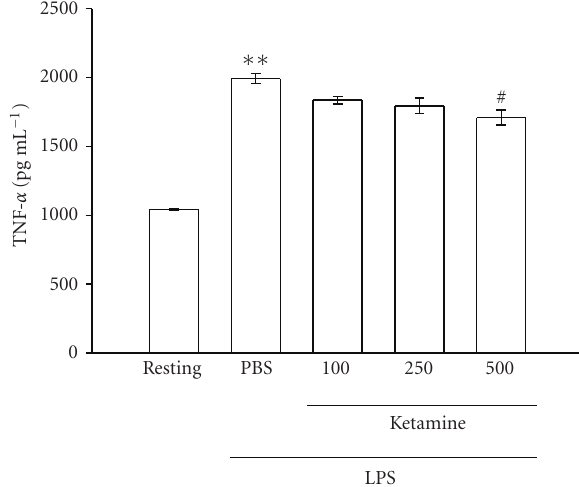
Figure 3: E ff ect of ketamine on interleukin (IL)-1 β production in lipopolysaccharide (LPS)-activated microglia. Microglia (5 × 10 5 cells mL − 1 ) were treated with ketamine (100 and 250 μ M) or an isovolumetric PBS bu ff er for 30 minutes, followed by the addition of LPS (100 ngmL − 1 ) for 12 hours. Cell-free supernatants were assayed for IL-1 β production as described in Section 2. Data are presented as the means ± S.E.M. ( n = 3). ∗∗ P < . 01, compared to the resting group; # P < . 05 and ## P < . 01, compared to the PBS-treated group.